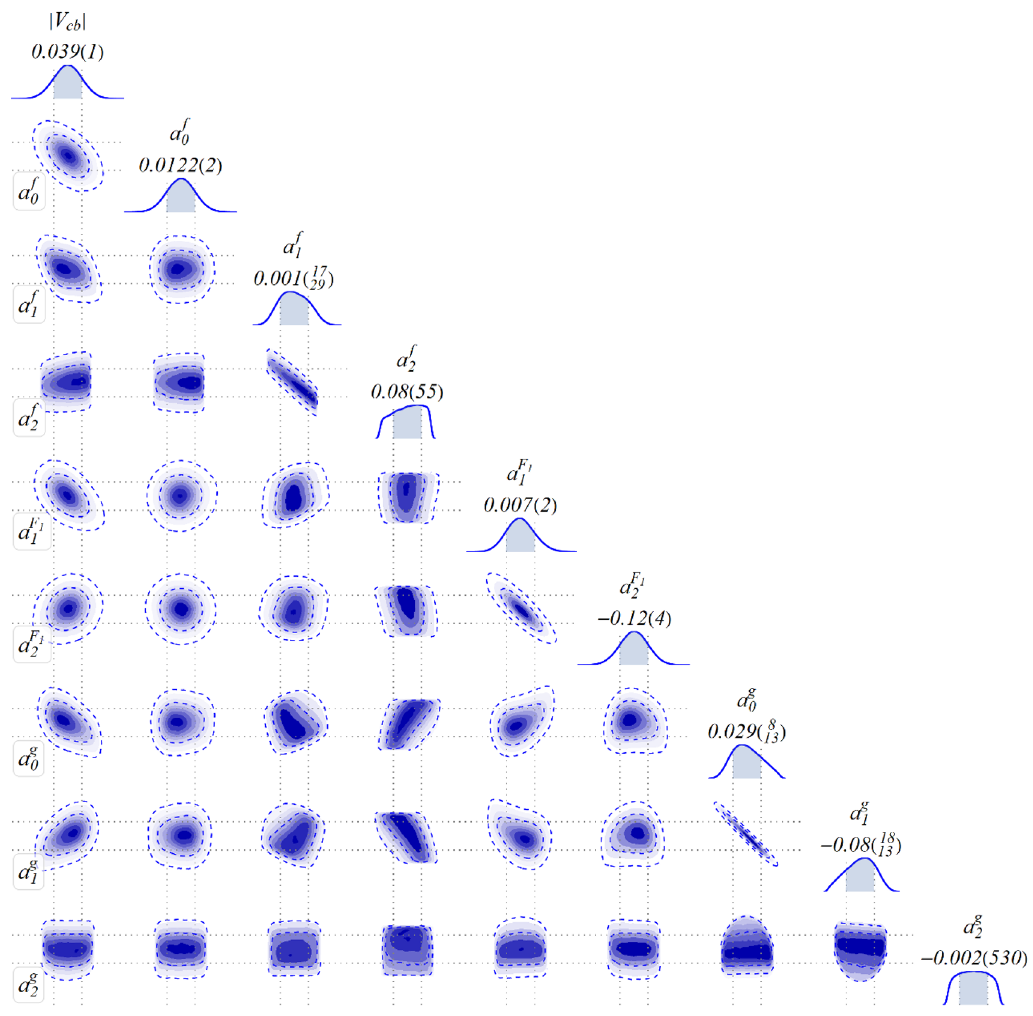
Figure 1. The Bayesian (cid:12)t results for all the BGL parameters of B ! D (cid:3) ‘(cid:23) ‘ form-factors corre- sponding to N = 2 obtained with 2019 Belle data (third column of table 4). The plot shows 1D and 2D (depicting the correlations) marginal probability distributions and the best-(cid:12)t values for the